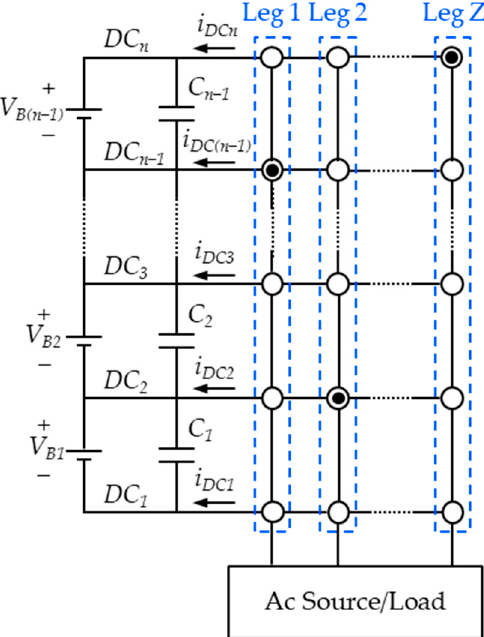
Figure 19. Functional schematic of an n -level Z-leg NPC DC–AC converter fed by (𝑛 − 1) batteries on the DC side and connected to a generic Z-phase source or load on the AC side. Each leg is represented as a single-pole n-throw switch. The switch position is indicated by a solid circle.